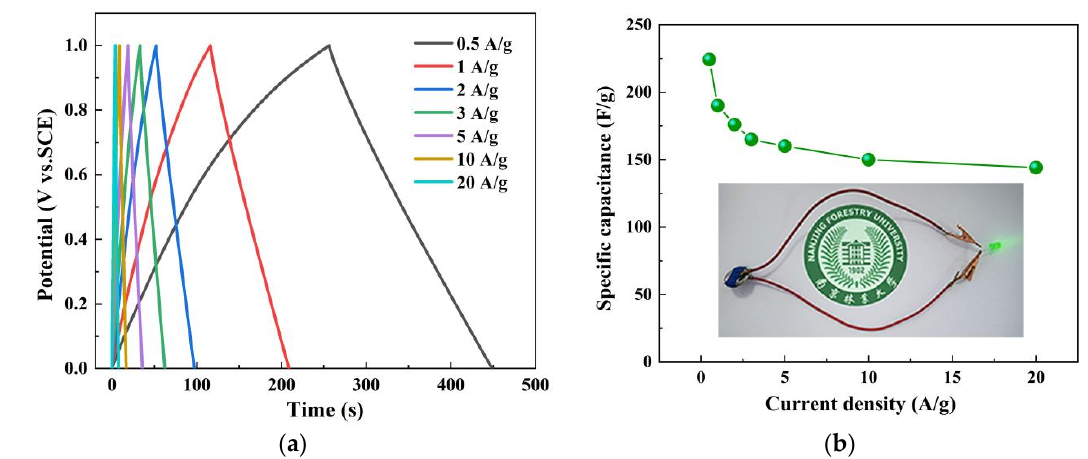
Figure 14. Galvanostatic charge/discharge curves of SNC700 at current densities from 0.5 to 20 A/g ( a ); gravimetric specific capacitances at various current densities (inset photo of the supercapacitor lighting up the LED) ( b ).